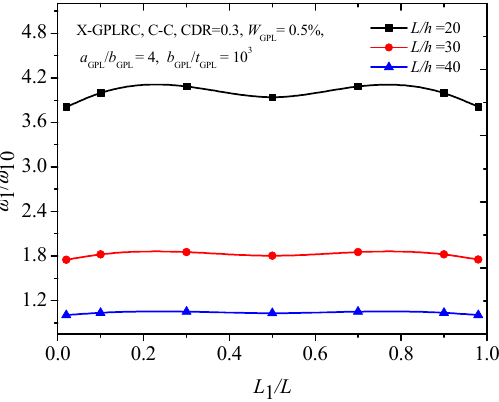
Figure 7. Effect of slenderness ratio on fundamental frequency of C-C cracked FG-X-GPLRC beam.